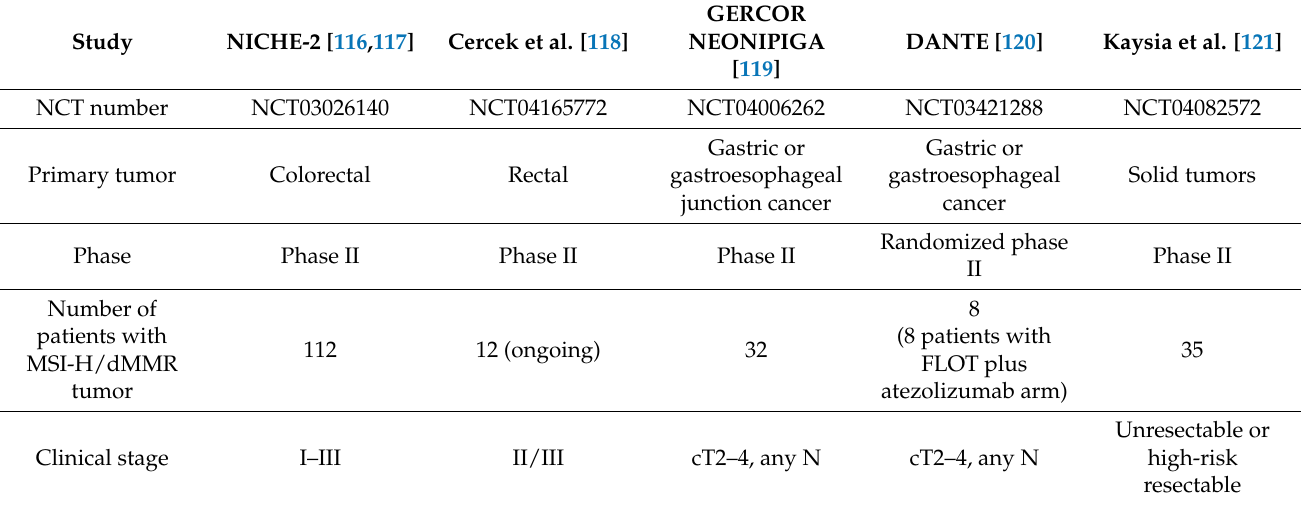
Table 4. Neoadjuvant immunotherapy in MSI-H/dMMR gastrointestinal